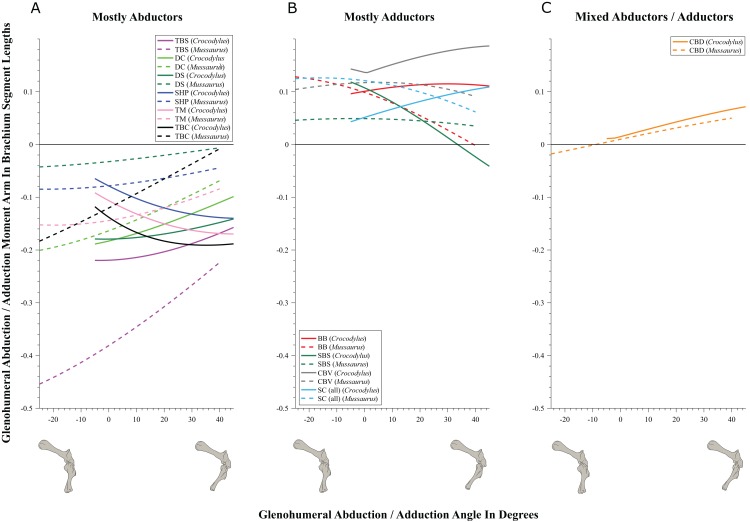
Abduction/adduction moment arms around the glenohumeral joint, normalized to humerus segment length, plotted against abduction/adduction joint angles for Crocodylus and Mussaurus in the resting pose.(A) Mostly abductors; (B) mostly adductors; (C) mixed abductors/adductors. Negative moment arms and glenohumeral angles correspond to abduction, while positive values correspond to adduction. For muscle abbreviations see Table 1. For a similar plot using glenohumeral extension/flexion joint angle on the x-axis, see Fig. S9.